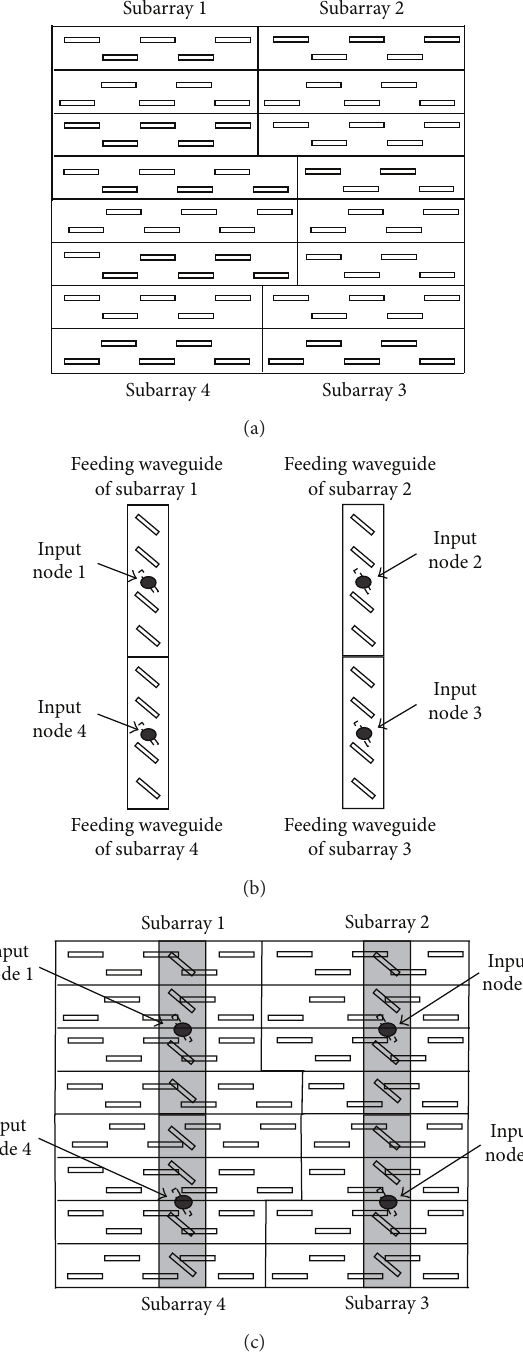
̂𝑁 𝑚 (on the right hand) and